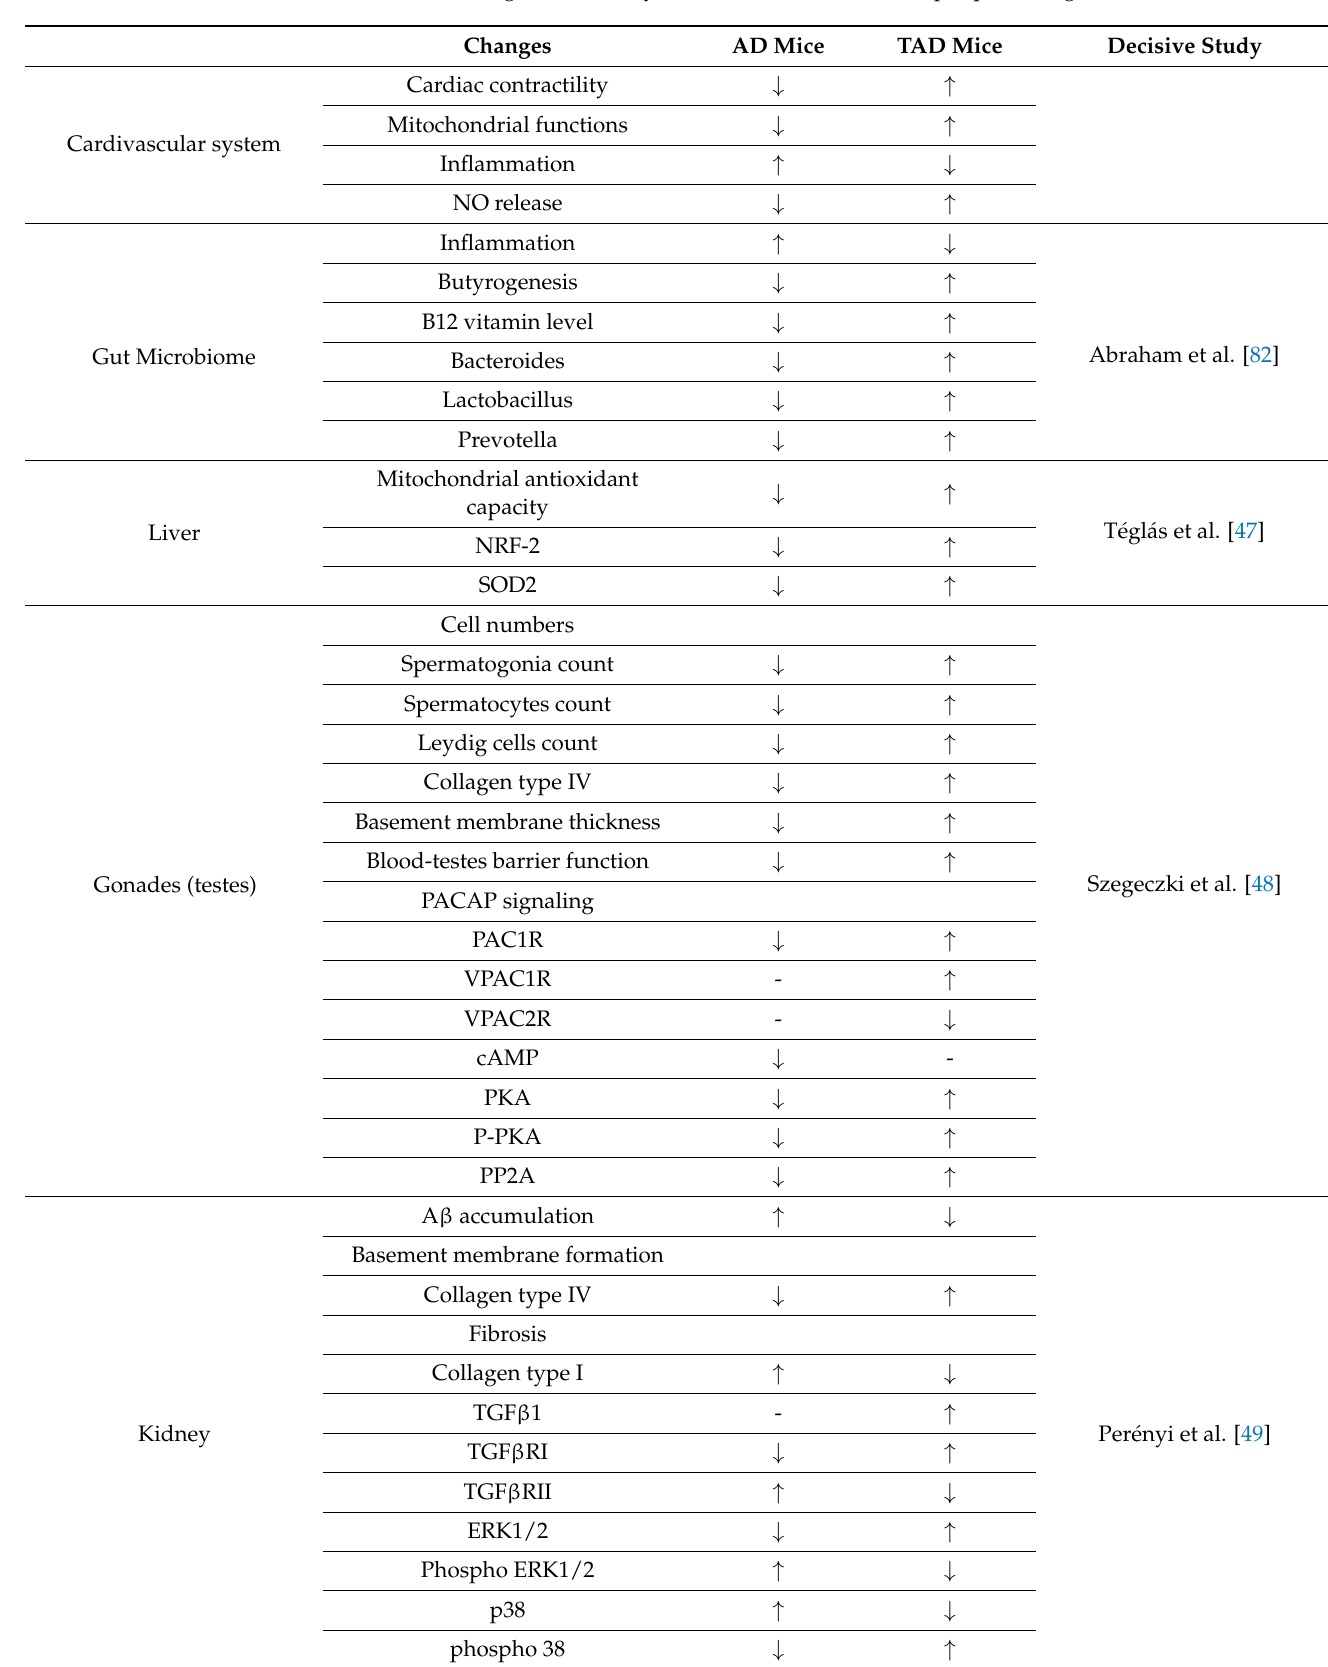
Table 1. Investigation of the systemic effects of exercise on peripheral organs in